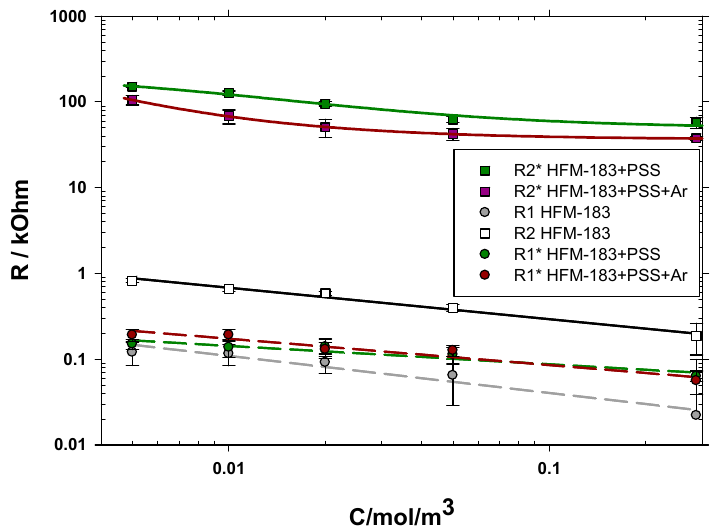
Figure 8. Resistances for the pristine membrane, the PSS recovered one, and the plasma-treated one are shown as a function of the K 2 CrO 4 concentration.